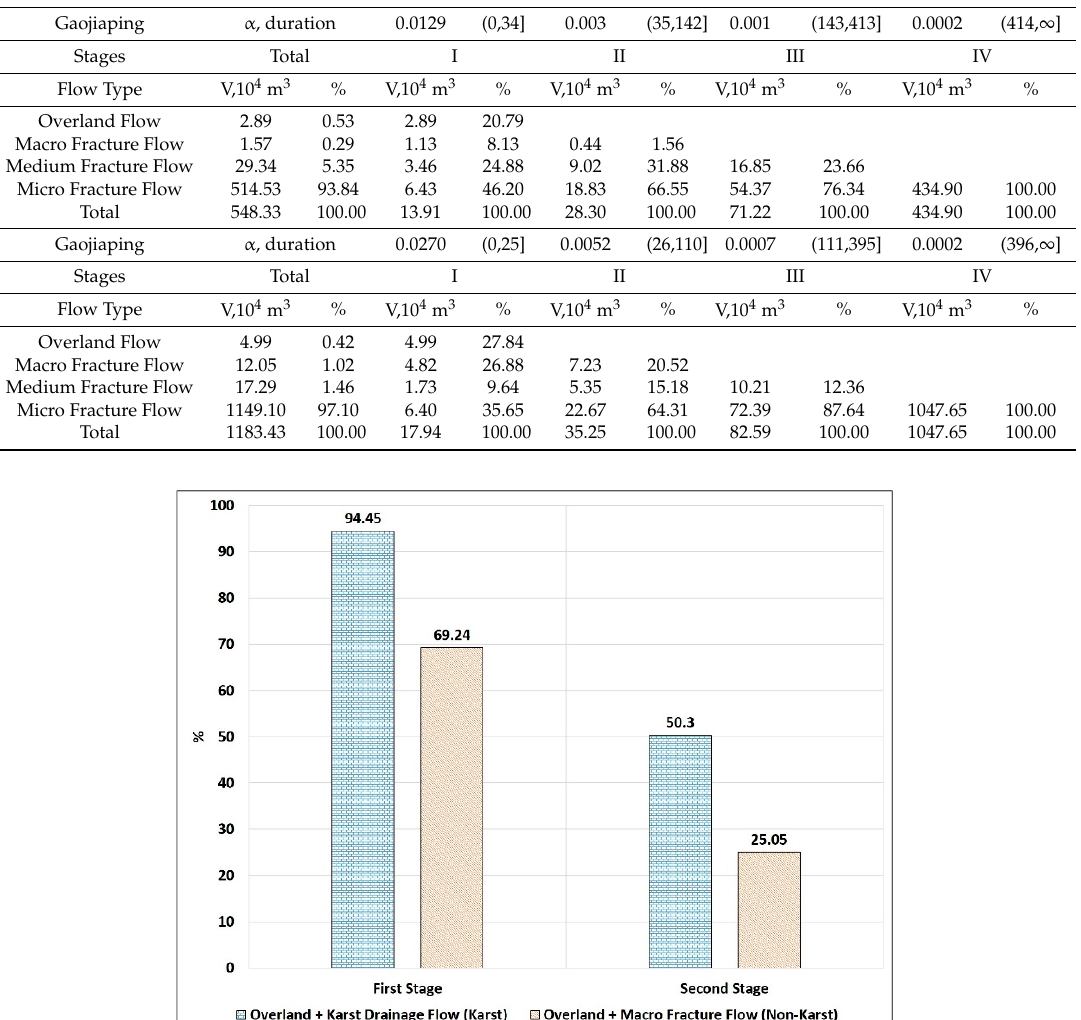
Figure 12. Contrast in Micro Fracture Flow Volume for all four recession stages. 3.7. Implications on Groundwater Availability and Quality in Karst Areas High recession coefficient watershed for successive stages of the recession hydrograph has implications on the availability of groundwater especially during dry periods with no precipitation [17]. Fiorillo et al. [17] also reports that when the recession coefficient decreases or increases, the